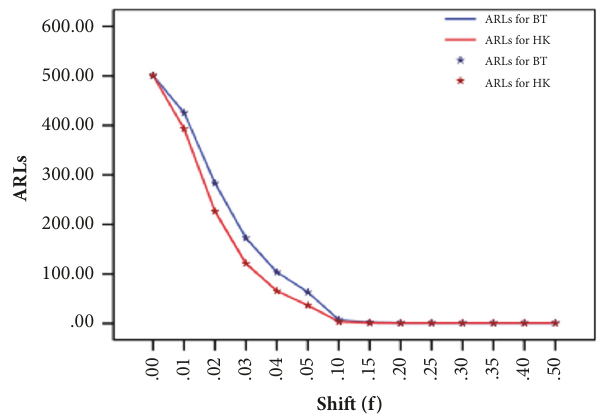
Figure 13: ARLs for proposed repetitive EWMA-RSS control charts using ratio estimators, for 𝜌 = 0.25 when 𝑟 𝑜 = 500 at 𝜆 = 0.1.